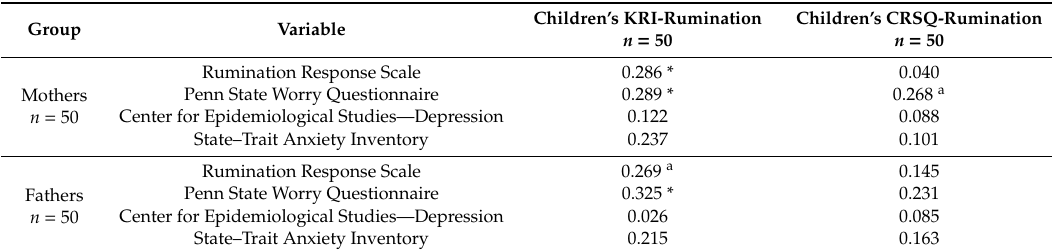
Table 3. Pearson correlations between parents’ variables and the variables referring to their children’s levels of